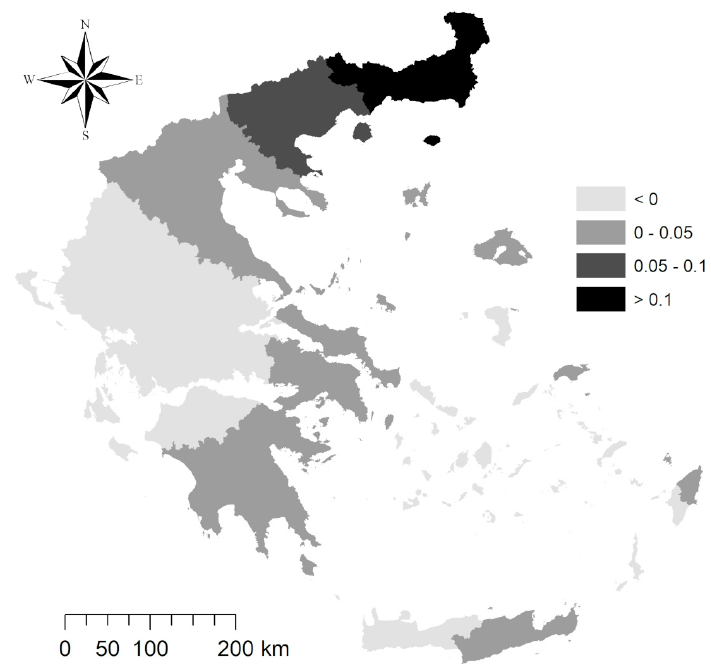
14 of 22 Figure 8. Absolute change in the GWR regression coefficient (local slope) during two consecutive